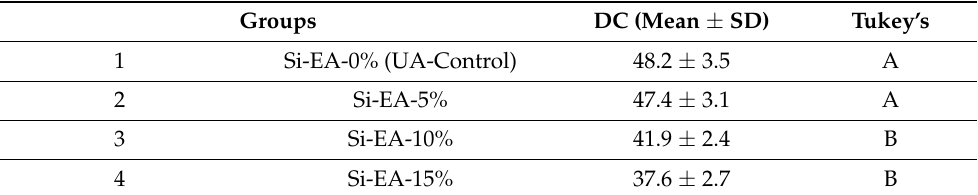
Figure 5. Fourier transform infrared (FTIR) spectrum of polymerized and un-polymerized unfilled adhesive (UA) and three test groups with 15%, 10% and 5% silica-experimental adhesive (Si-EA). The degree of conversion was calculated by estimating the changes in the peak height ratio of the absorbance intensities of the aliphatic C=C peak at 1638 cm − 1 and that of an internal standard peak of aromatic C=C at 1608 cm − 1 during polymerization, in relation to the uncured adhesive, as indicated by dotted lines. Table 2. Means (SD) for the degree of conversion (%) values among study groups using ANOVA and the Tukey multiple comparisons